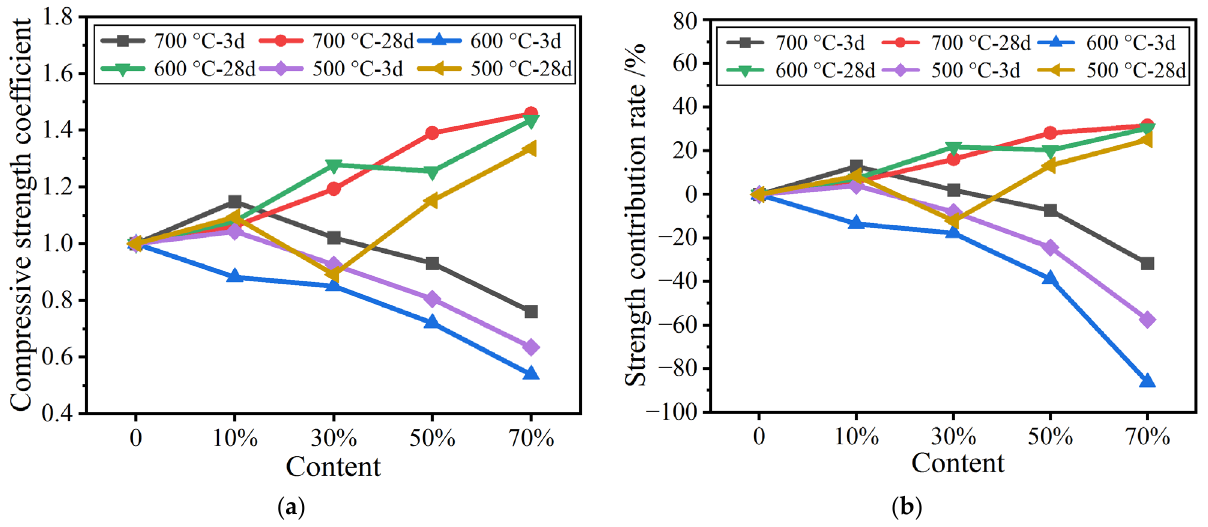
Figure 5. ( a ) Specific compressive strength coefficient; ( b ) Strength contribution rate .